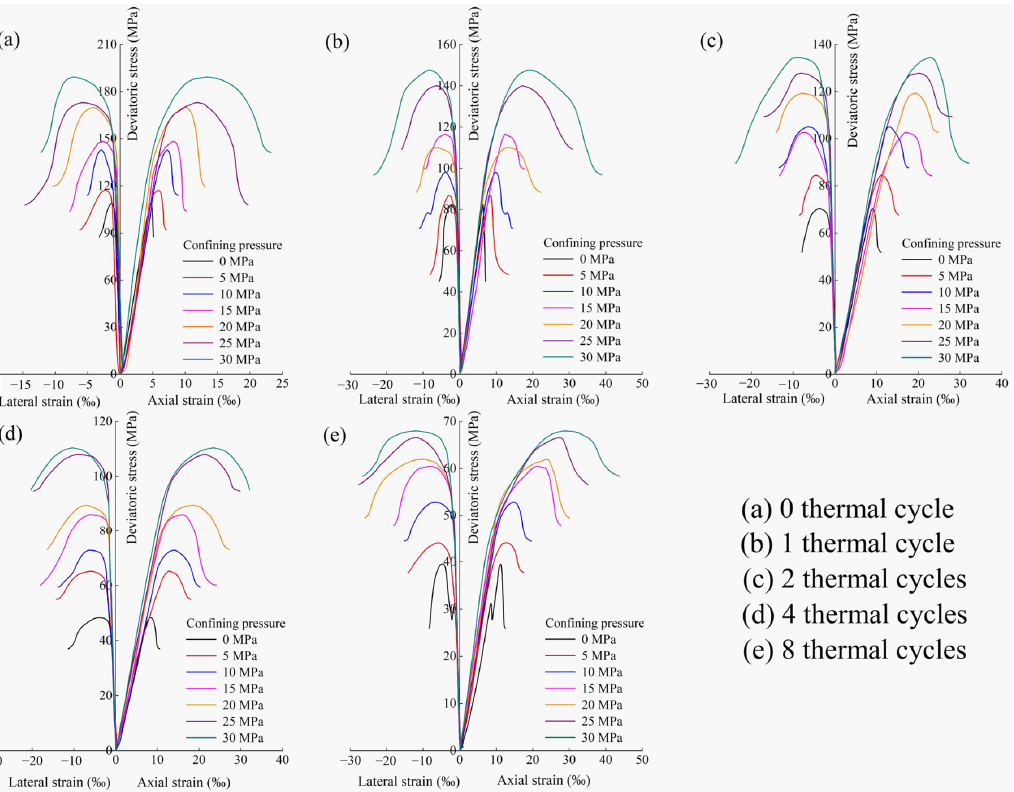
Figure 5. Complete stress ‐ strain curves of marble specimens in triaxial compression under different thermal cycles.